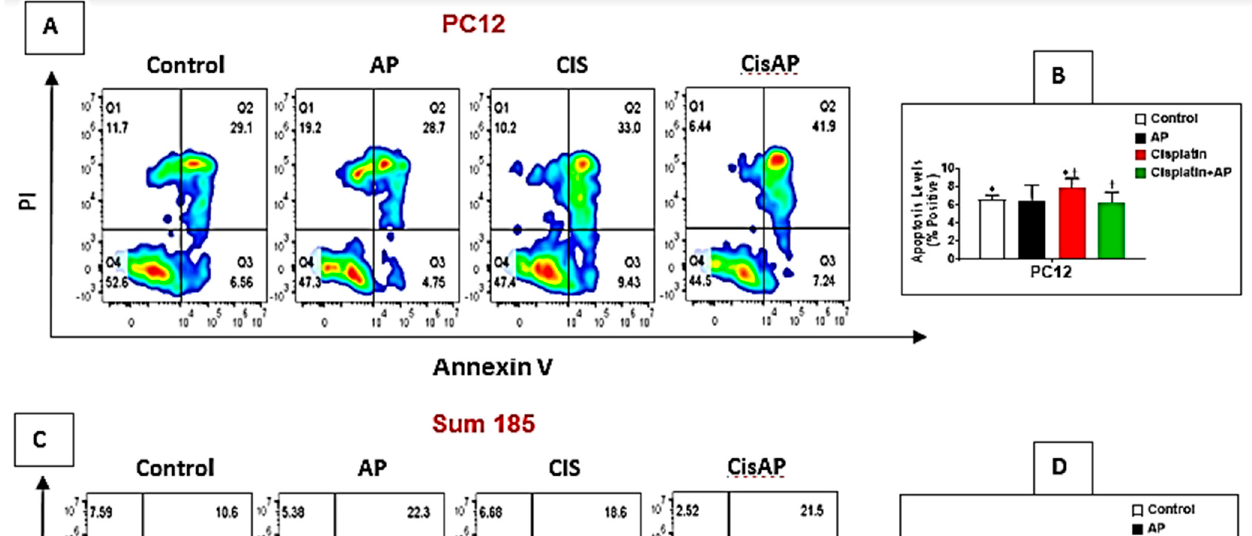
Figure 4. NK1R Antagonism protects PC12 cells while causing enhancement of cisplatin-induced apoptosis in TNBC cells. PC12, Sum 185 and Sum 159 TNBC cells were untreated (media control) or treated with aprepitant or cisplatin alone or cisplatin + aprepitant, stained with Annexin V-FITC/PI and cell apoptosis analyzed by flow cytometry ( A , C , E ). Quadrant gating was made based on unstained controls. Q2 demonstrates necrotic cells, Q3 demonstrates apoptotic cells, and Q4 demonstrates viable cells. Levels of apoptosis (% positive) in the different groups in PC12 ( B ), Sum 185 ( D ) and Sum 159 cells ( F ) (* , † , ‡ , p ≤ 0.05, ANOVA, n = 2). Only statistical comparisons between control vs. AP or Cis and Cis vs. Cis + AP are shown.